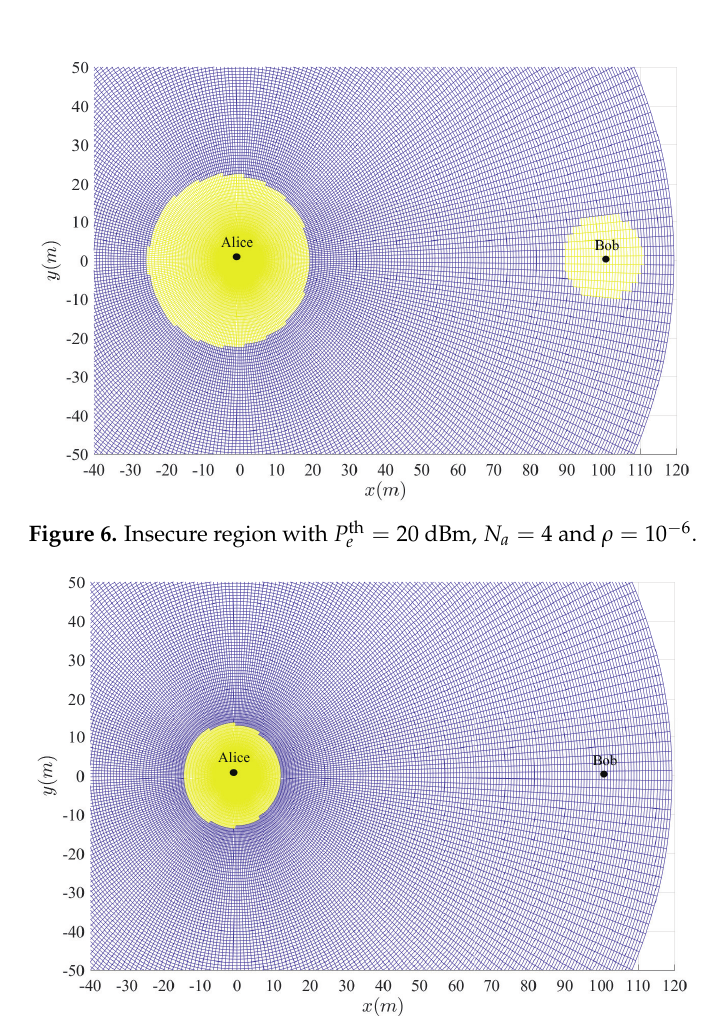
Figure 7. Insecure region with passive Eve and N a = 4 and ρ = 10 − 8